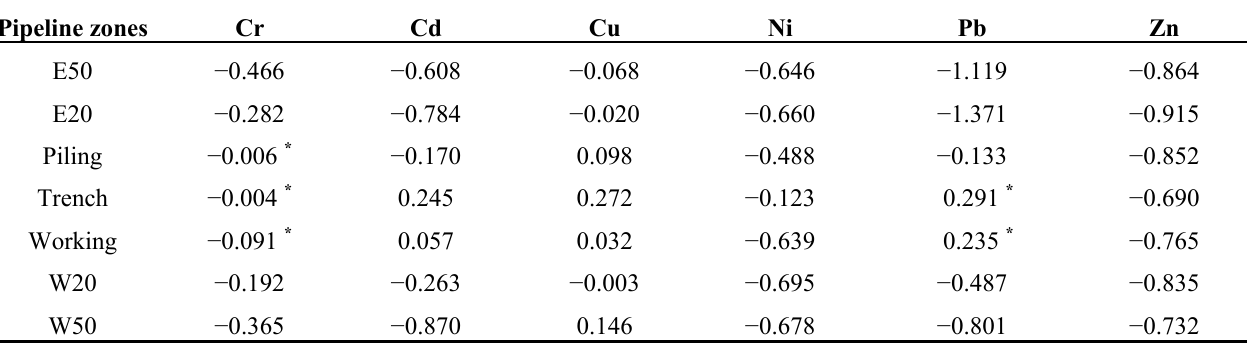
Table 4. Index of Geo-Accumulation in Pingliang (Site 1).